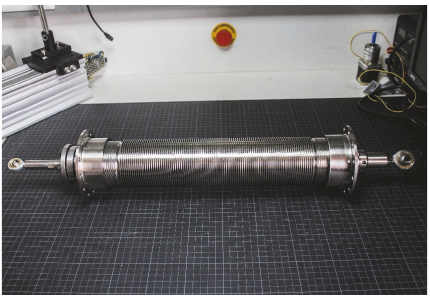
Figure 6: 𝑍 -transmitter prototype.